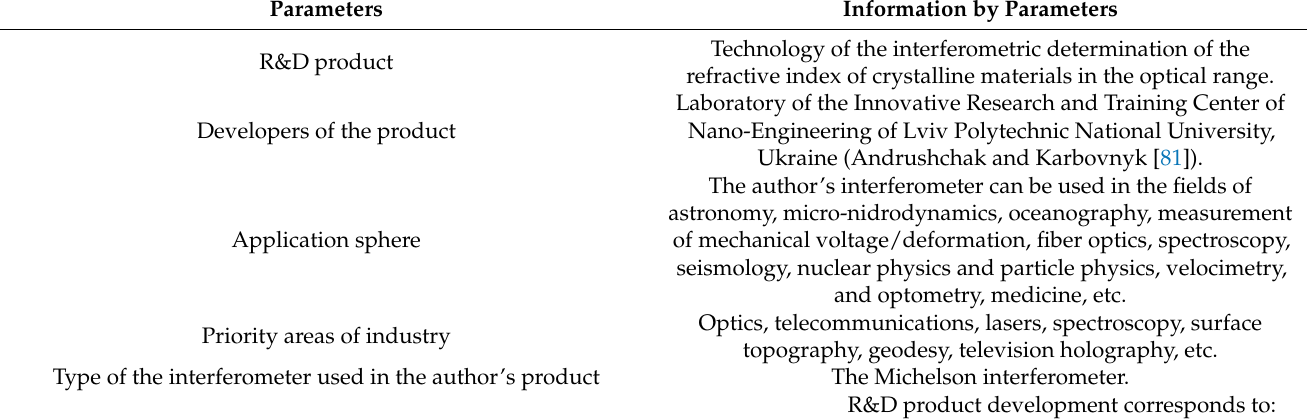
Table 1. Technical and economic parameters of the R&D product of the interferometric determination of the refractive index of crystalline materials in the optical range 1